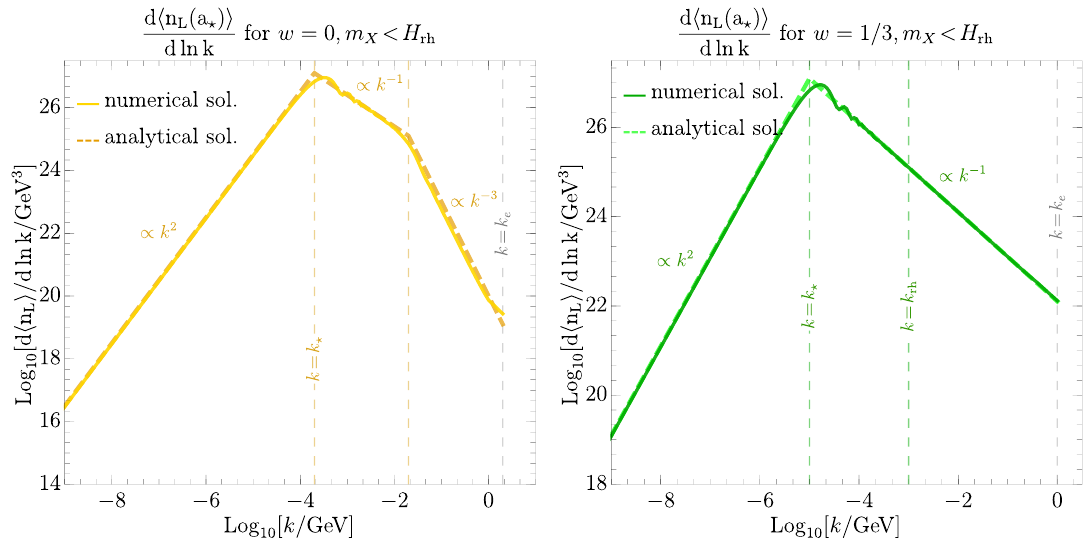
Figure 8 . Comparison between numerical results (solid lines) and analytical predictions for the expectation value of number density per log momentum for w = 0 (left-panel) and w = 1 = 3 at a = a ? . The same parameters as in (cid:12)gure 7 have been